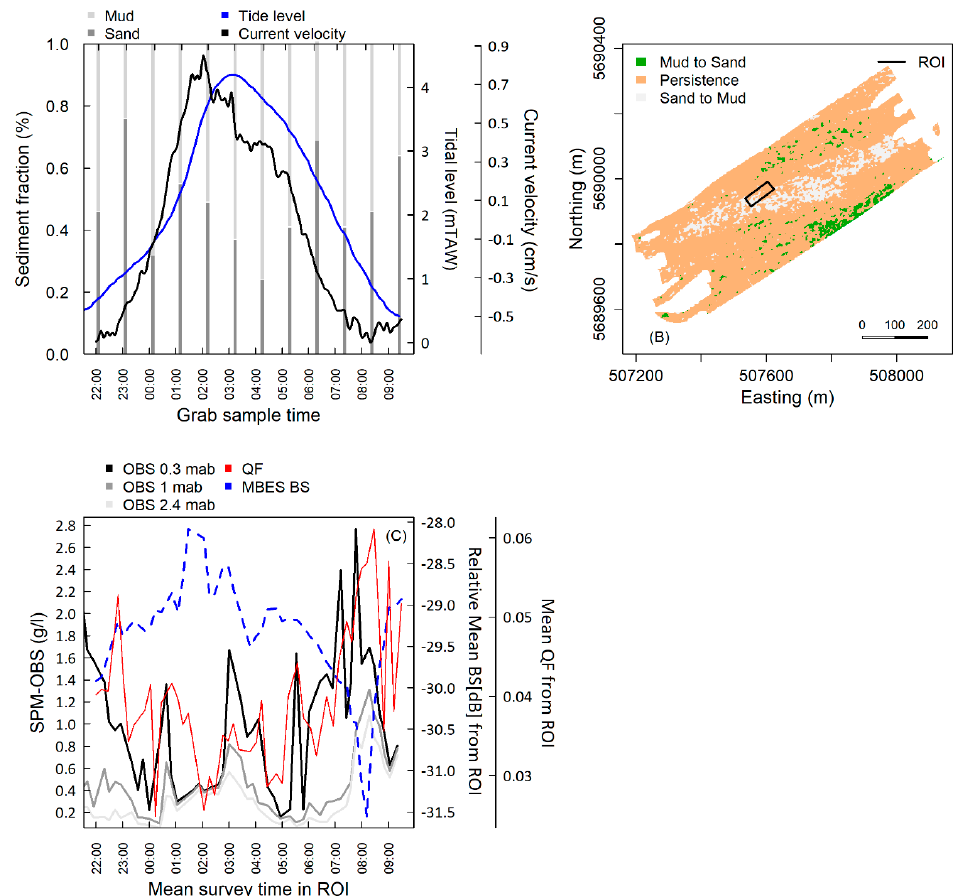
Figure 10. ( A —top left quadrant) Variation in particle size of the first centimetre of the Reineck box-cores time series ( n = 12, collected approximately every hour—the above x axis indicates their real position in respect to the tidal cycle), together with the tidal level and the current velocity (respectively blue and black lines, right axis); ( B ) Bi-temporal image differencing (algebraic) change detection between maps of 21st and 24th November 2017 (pre- and post-experiment) summarized into 3 categories of persistence and from-to transitions. Green : Mud to Sand transition; Orange : Persistence; and Grey : Sand to mud. Black rectangle : the ROI; ( C ) SPMc derived from the OBS sensors chain ( continuous lines, left axis ), mean MBES BS from the ROI ( dashed blue line, right axis ) and mean Kongsberg QF ( continuous red line ). Table 6. Correlation matrix obtained by the Spearman rank method (lower triangle shown). Significance levels of the correlations are denoted by asterisks: Legend of the significance in the bottom row of the table.